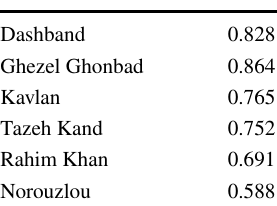
Table 6 The estimates of the ITI index for the rain-gauge monitoring network in the